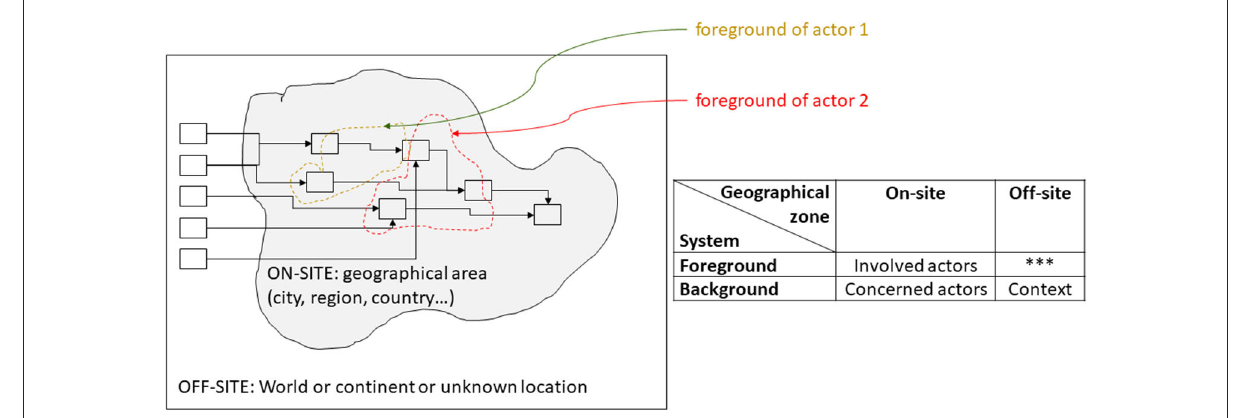
FIGURE1 Conceptual representation of foreground and background systems in the source geographical